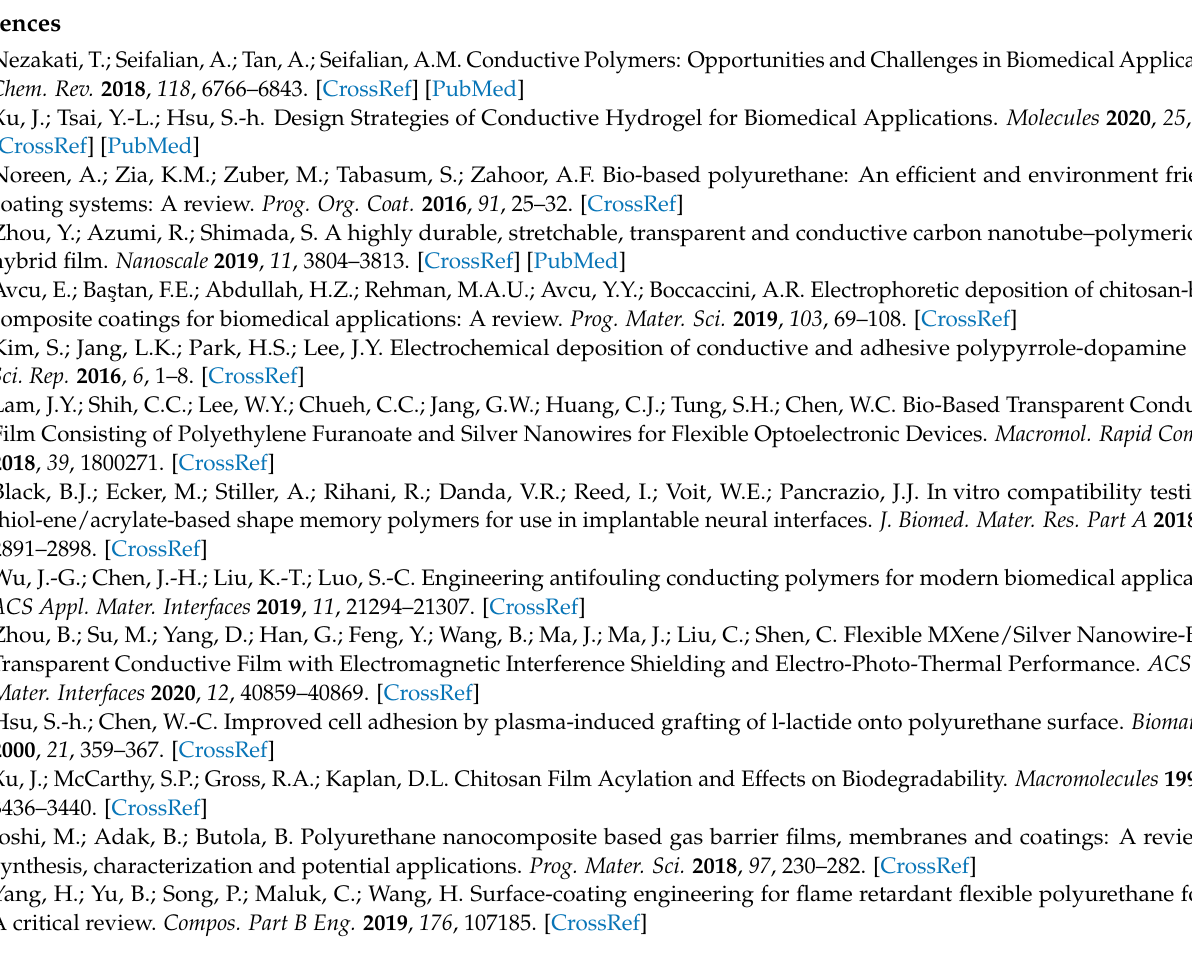
view. Figure S2: The TGA curve of DCP. Figure S3: Testing of DCDFs as a potential coating. Movie S1: Cell morphology. Continuous changes of cell morphology and the movement of NSCs on the DCD thin film within 24